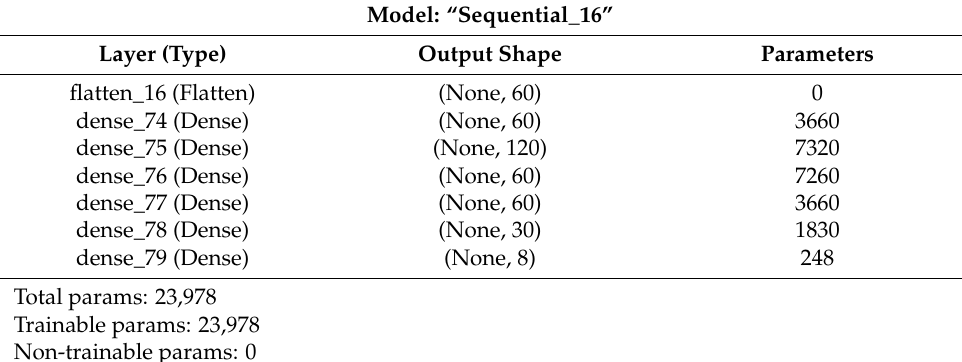
Table 8. TModel1